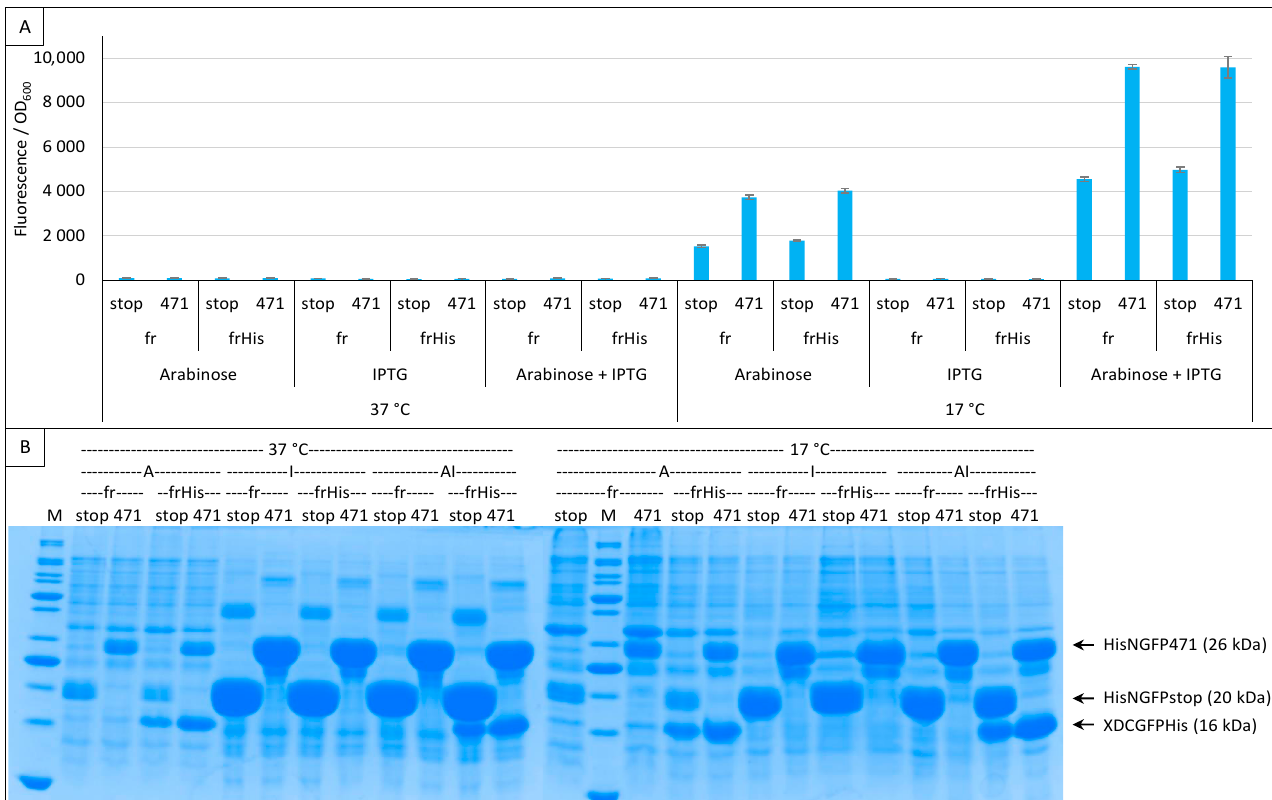
27 ◦ C and 17 ◦ C. In the case of fr, results obtained using His-tagged (frHis) and non-His-tagged (fr) XD-CfrGFP are shown. ( A ) Fluorescence to OD 600 ratios. ( B ) SDS-PAGE analysis of the expression of the NGFP and CGFP fusions. M, molecular size markers (200, 150, 100, 85, 70, 60, 50, 40, 30, 25, 20, 15, 10 kDa).